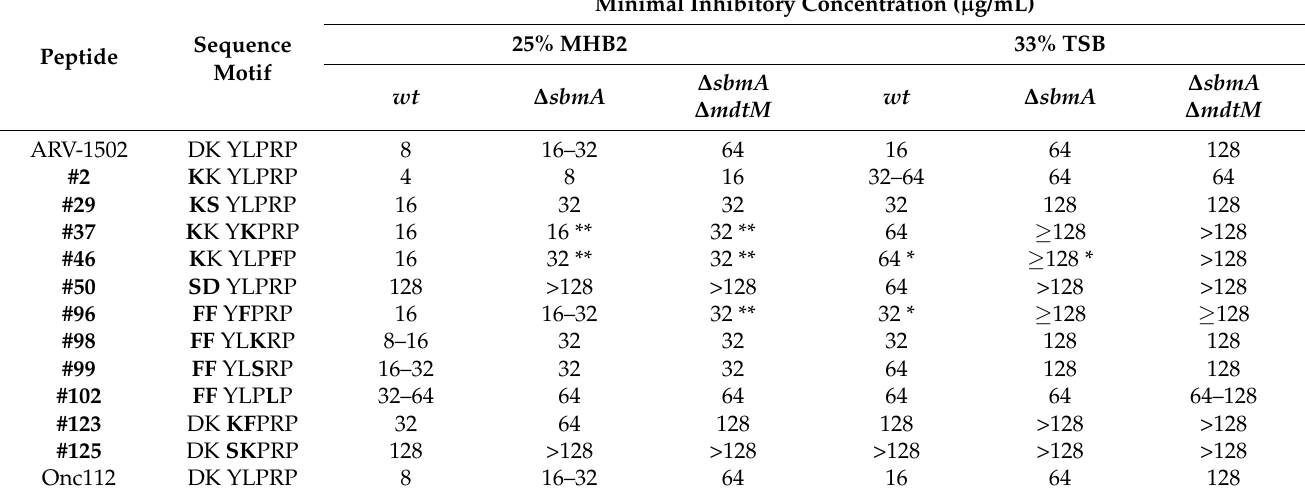
Table 2. MIC values determined for E. coli BW25113, BW25113 ∆ sbmA , and BW25113 ∆ sbmA ∆ mdtM